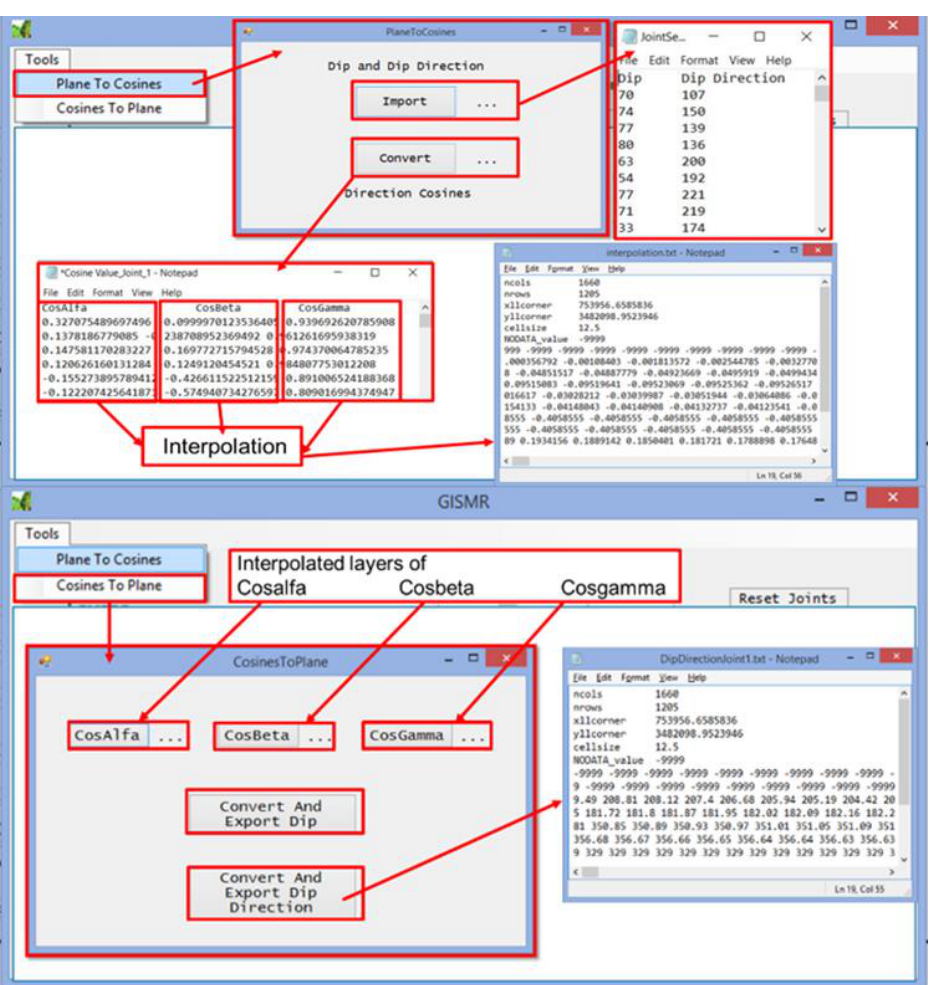
Figure 7. The screenshot of the GISMR application shows “Plane To Cosines” function, which is capable of importing planar or linear orientations in a text file in dip and dip direction format and converting into cosine values.